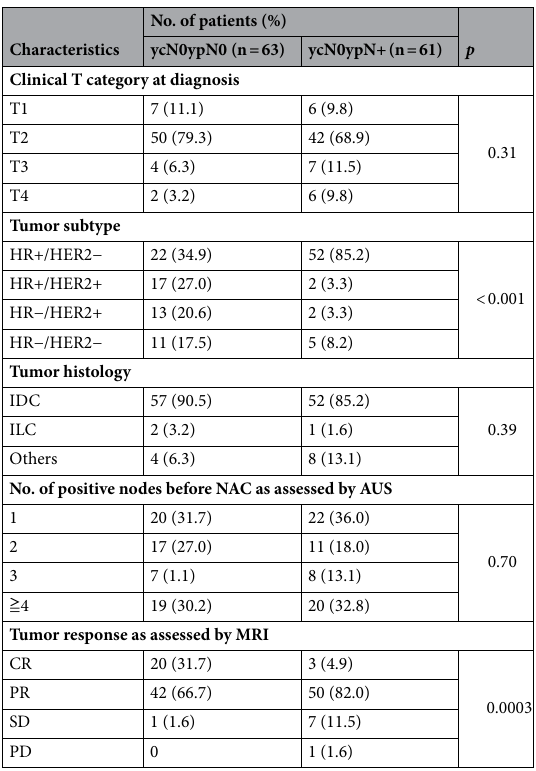
Table 4. Comparison of tumor characteristics between patients with ycN0ypN0 and ycN0ypN+. HR hormone receptor, HER2 human epidermal growth factor receptor 2, IDC invasive ductal carcinoma, ILC invasive lobular carcinoma, AUS axillary ultrasound, NAC neoadjuvant chemotherapy, ALND axillary lymph node dissection, CR complete response, PR partial response, SD stable disease, PD progressive